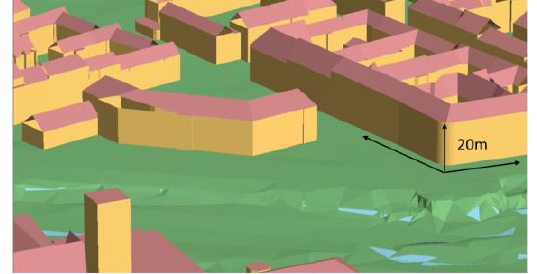
Figure 7: CityGML model representing the current state of the city.